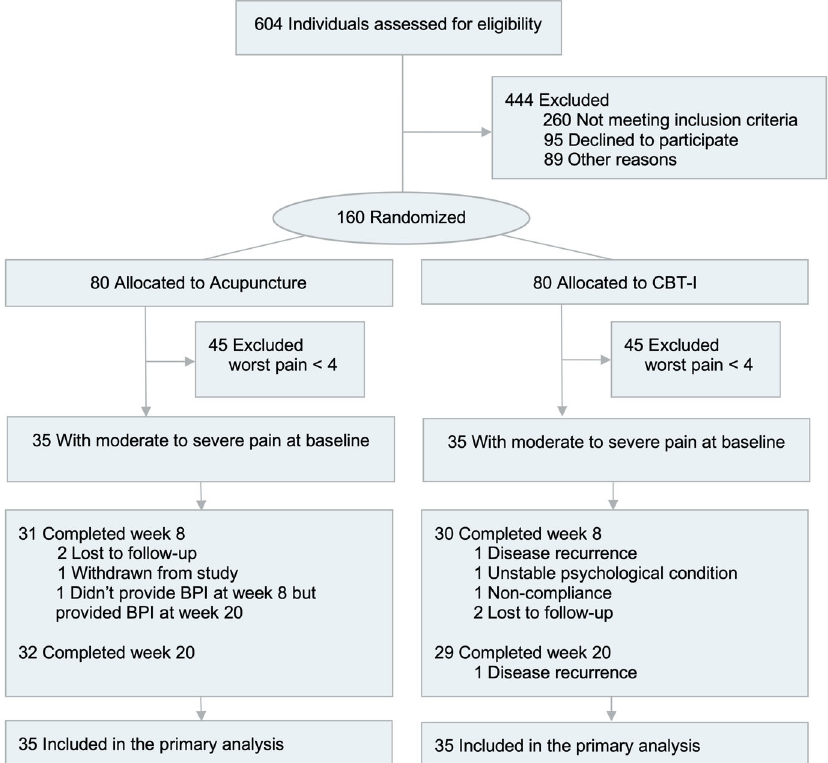
Fig. 1 Study fl ow chart. This study only included participants with comorbid insomnia and pain. Key: CBT-I cognitive behavioral therapy for insomnia, BPI Brief Pain